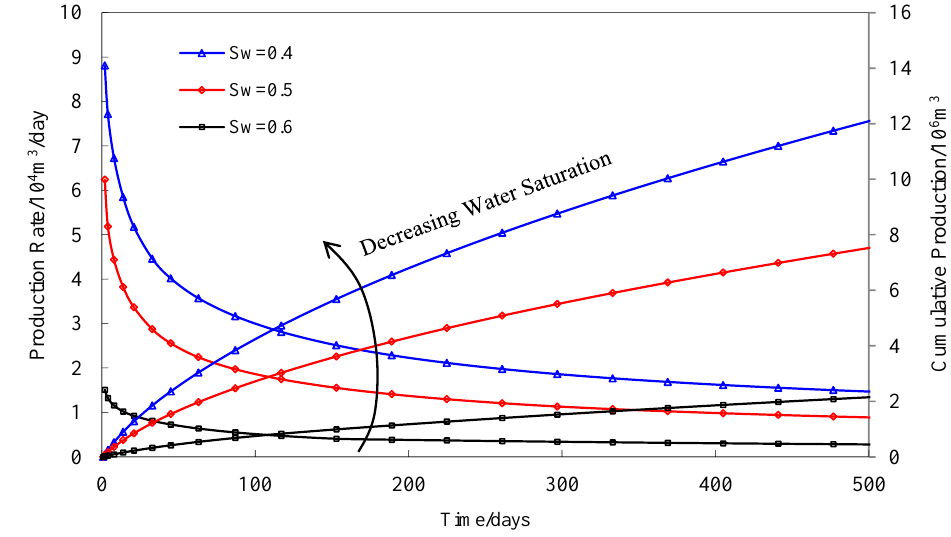
Figure 14. Effect of initial water saturation on gas production rate and cumulative production (decline curves represent gas production rate curves, increasing curves represent cumulative production curves).